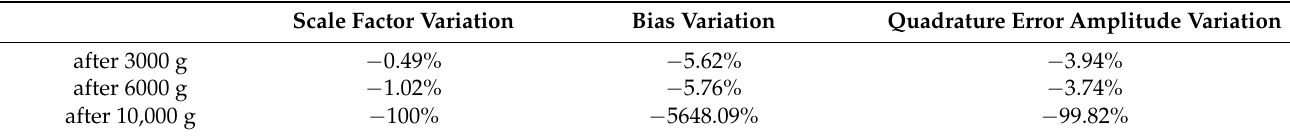
Table 3. The variation of scale factor, bias, and quadrature error amplitude after the impacts compared to the original value. Scale Factor Variation Bias Variation Quadrature Error Amplitude Variation after 3000 g − 0.49% − 5.62% − 3.94% after 6000 g − 1.02% − 5.76% − 3.74% after 10,000 g − 100% − 5648.09% −